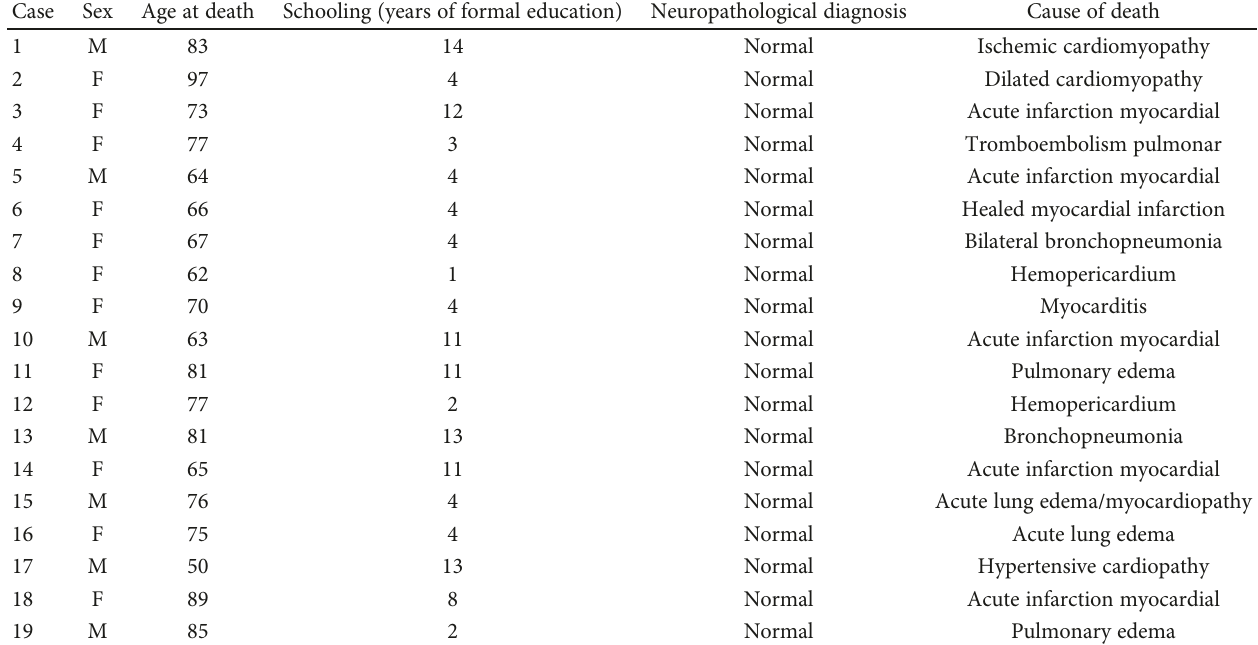
Table 1: Clinical data of all individuals classi fi ed as nondemented included in the paired analysis